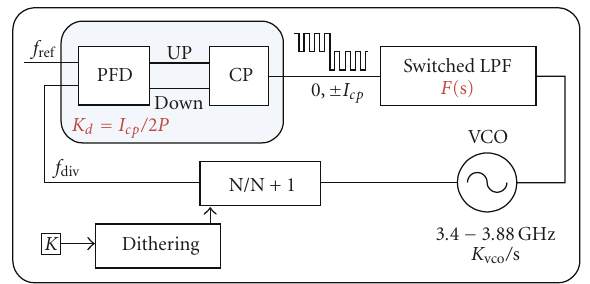
Figure 8: Linear model of a fractional- N charge pump synthesizer.